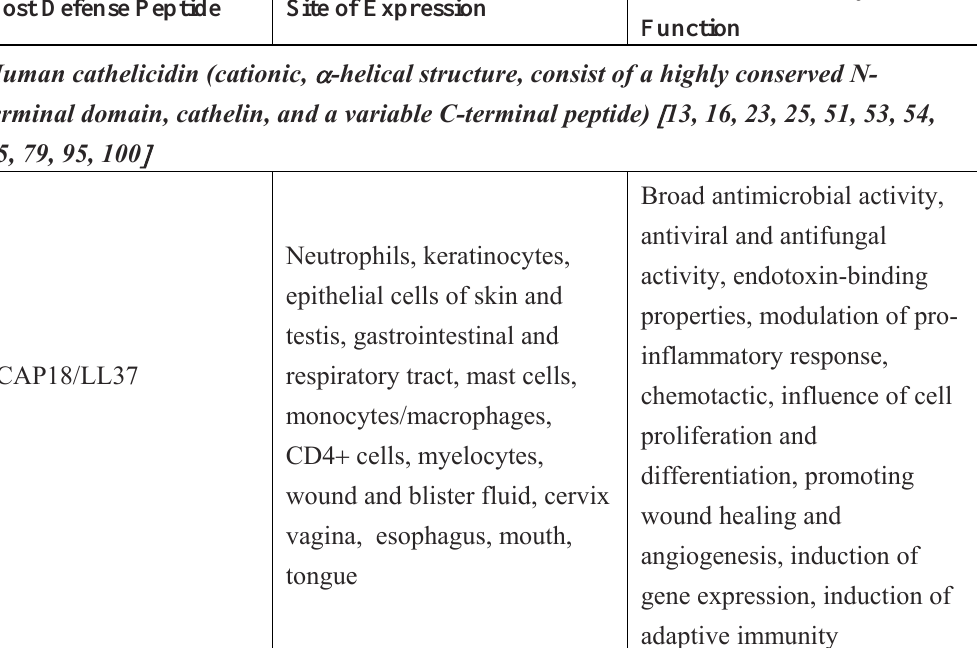
Table 1. Functions of HDPs in combating infections and modulating the immune response. Host Defense